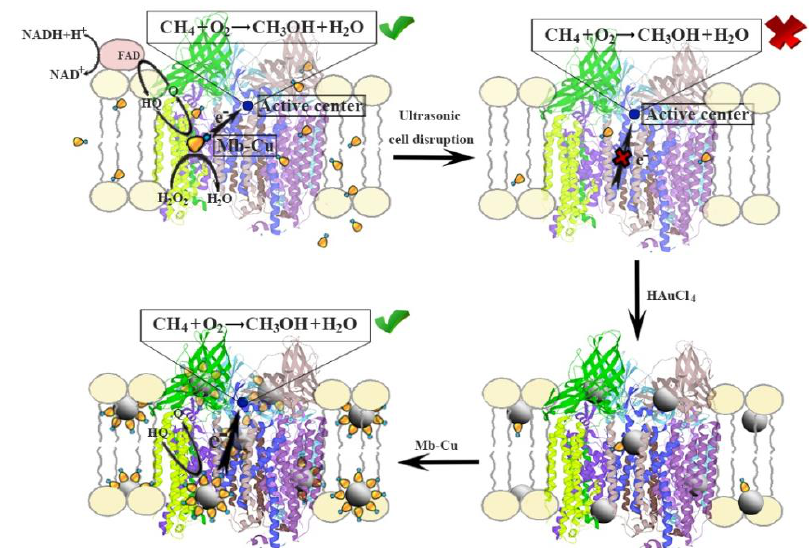
Figure 10. A schematic of the method used to fabricate the AuNP–pMMO nanobiohybrids. The